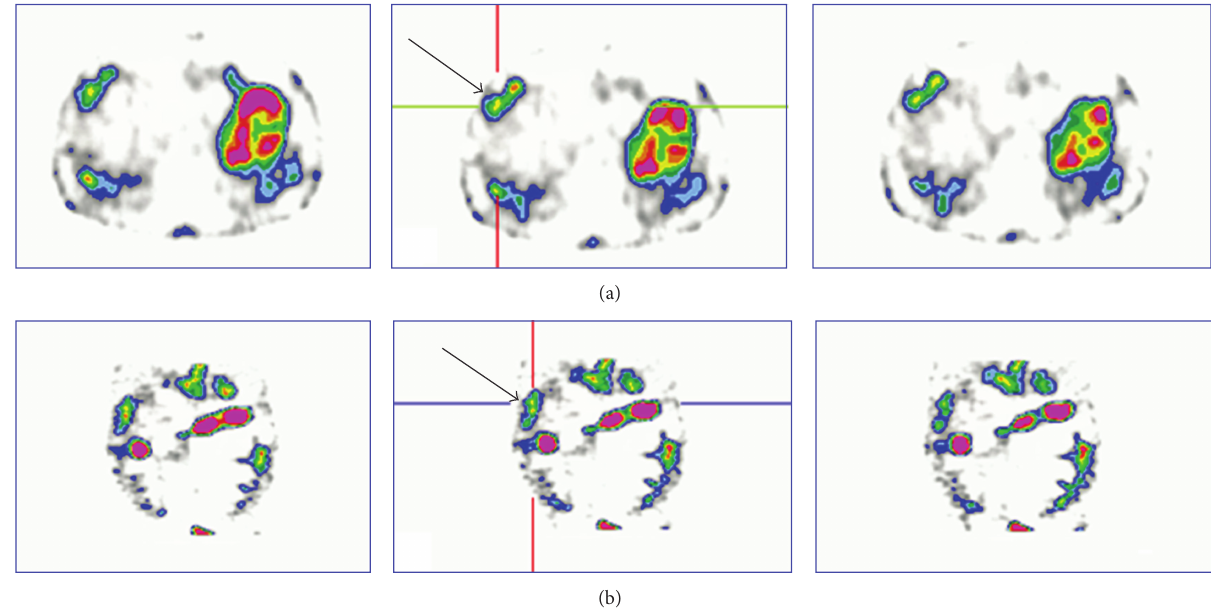
Figure 1: The positive results of GLP-1 receptor imaging in a 74-year-old patient (J.S.) with sporadic MTC; pathological uptake of the tracer in liver metastases is visualized. (a) Axial slices and (b) coronal